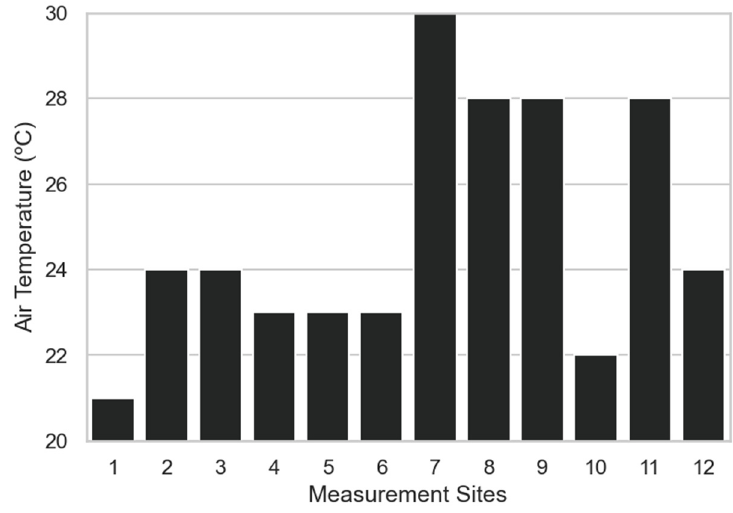
Figure 14. Average air temperature per measurement site.